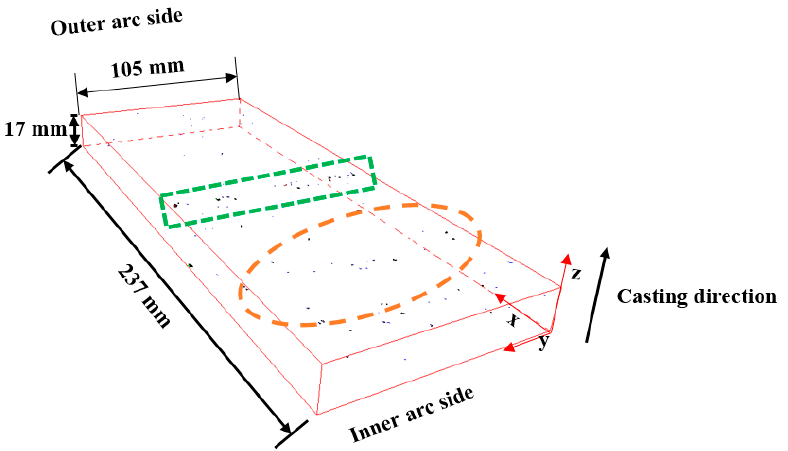
Figure 6. Three-dimensional distribution diagram of nonmetallic inclusions at different angles in the center sample of the slab.